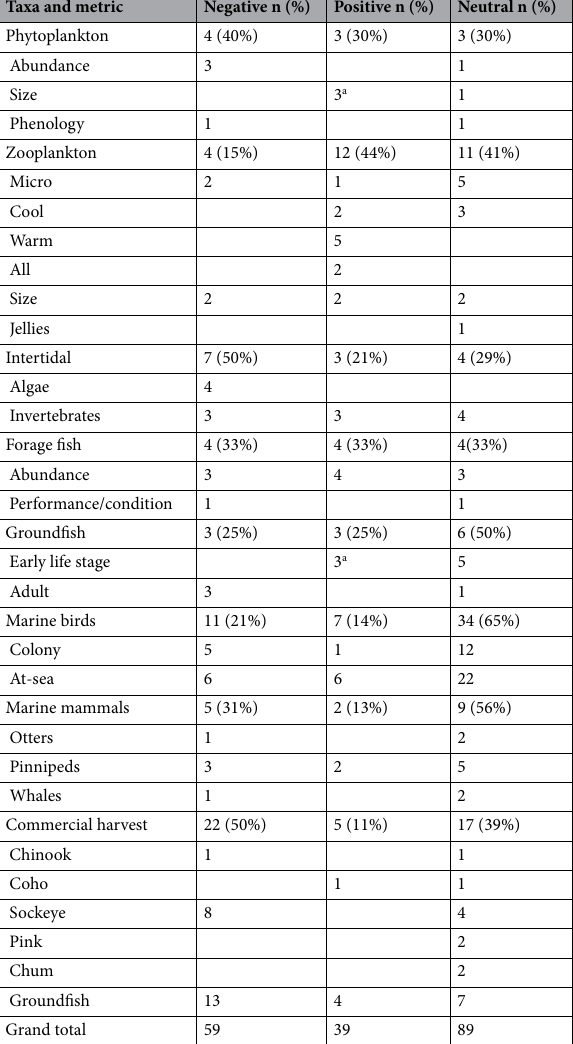
Table 2. Summary of trends based on factor loadings from dynamic factor analysis (DFA) by taxa and metric of 187 biological time series. Each time series is described as having a negative, positive, or neutral response (trend) coincident with the 2014–2016 Pacific Marine Heatwave. Negative, positive, or neutral responses are determined by DFA loadings of ≥ 0.20, ≤ -0.20, or > -0.20 and < 0.20, respectively. The signs of factor loadings are opposite of time series response because factor loadings describe how a given time series relates to the common trend, which was negative during the PMH (Fig. 3a). See Table S1 for factor loadings of individual time series a cell size of phytoplankton and abundance of juvenile pollock declined during strongest heatwave years, but increased above pre-heatwave levels resulting in a positive model trend